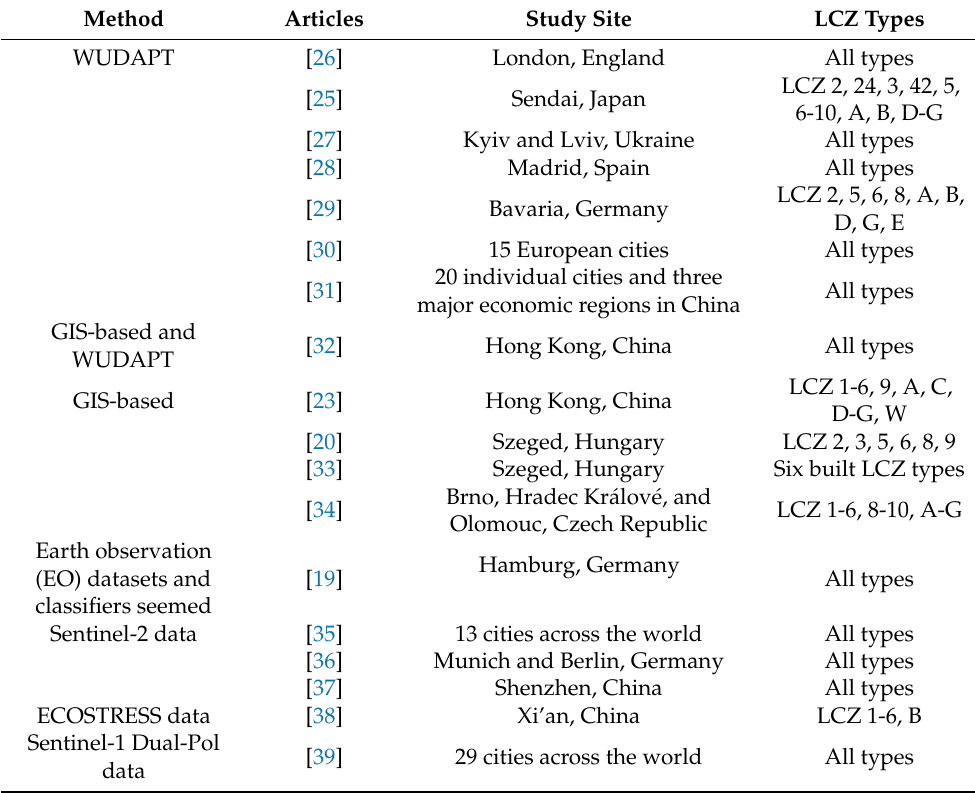
Table 3. Basic analytical methods used in LCZ